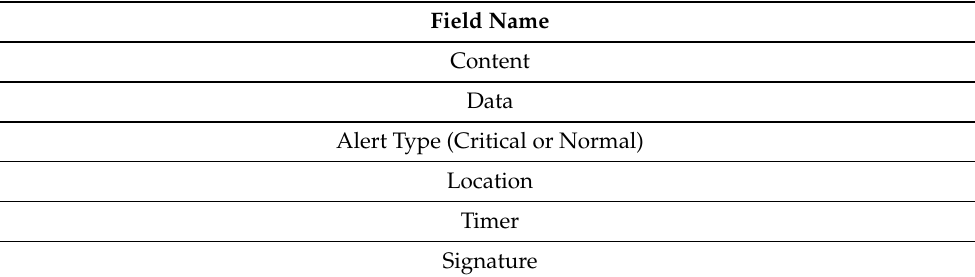
Table 1. The proposed data packet format.